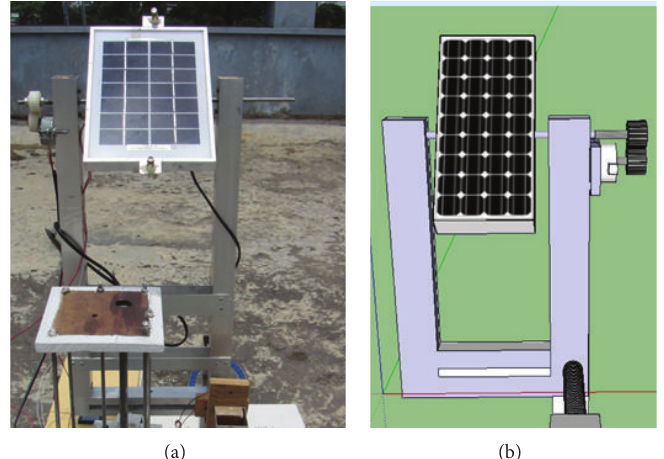
Figure 3: Design and implementation of panel carrier: (a) implementation and placement of panel carrier with the linear actuator and panel carrier rotator; (b) hardware design of Panel carrier in computer aided drafting tool.